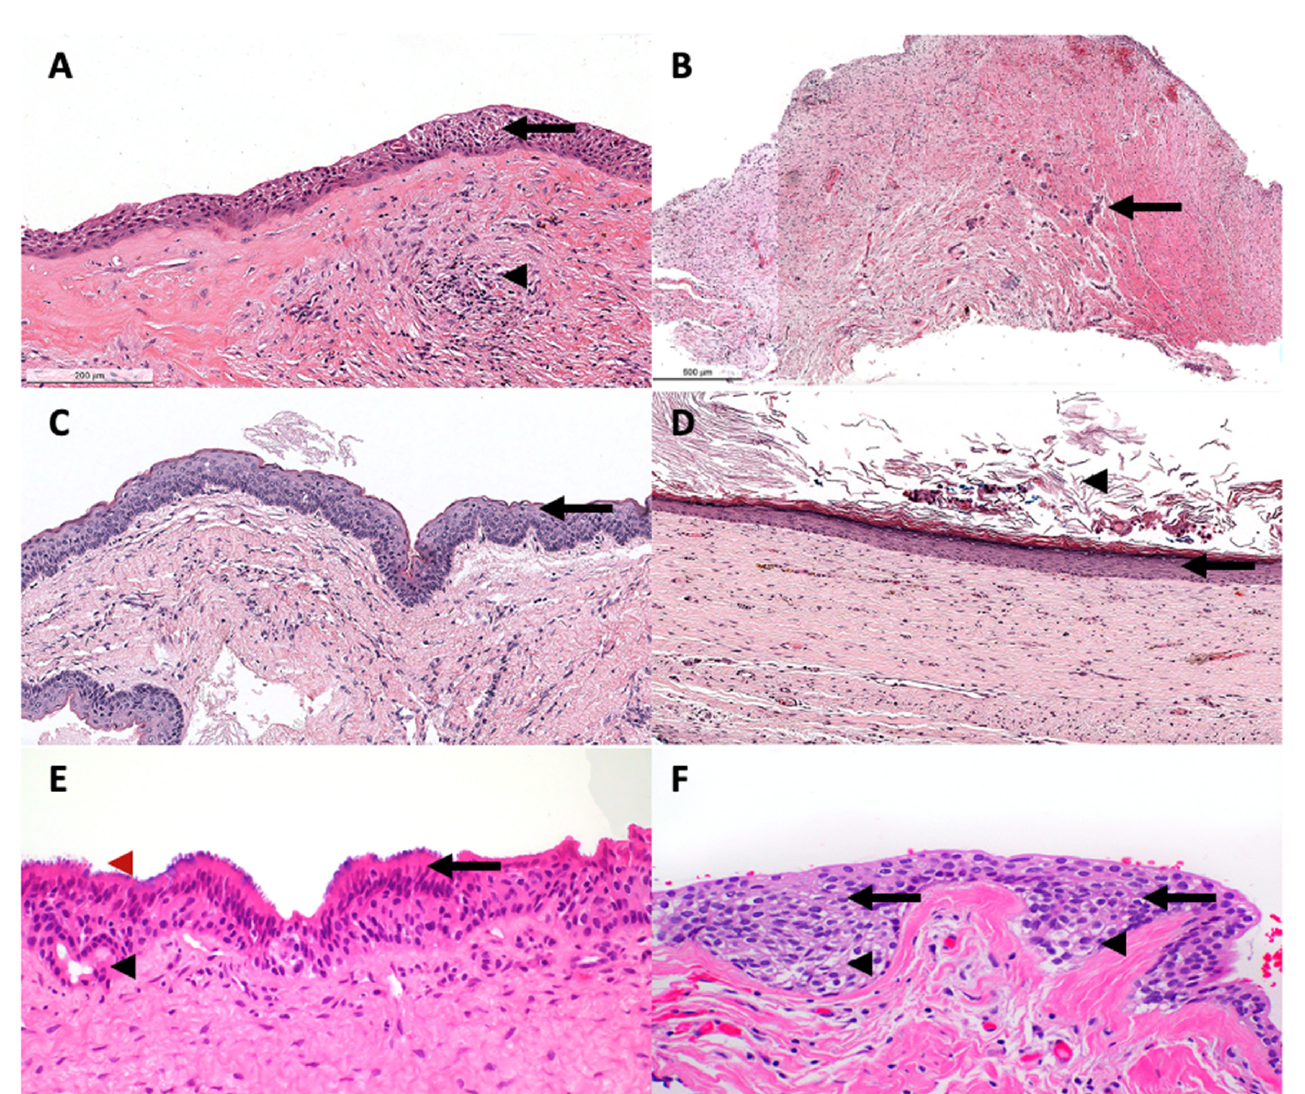
Figure 1. A representative histological photomics of developmental OCs. ( A ) DC is lined by uni- formly thin nonkeratinized squamous cell epithelium (arrow) with fibrovascular wall and scattered inflammatory cells (arrowhead). EC show similar histological features to DC; however, located in the lamina propria ( B ) Hyperplastic dental follicle consists of delicate fibrocollegenous stroma with scattered odontogenic epithelial islands (arrow). ( C ) OKC is lined by uniformly thin parakeratinzed squamous cell epithelium with surface corrugation and hyperchromatic basal cell layer (arrow). ( D ) OOC is lined by uniformly thin orthokeratinized stratified squamous epithelium (arrow) with keratin debris within the cyst lumen (arrowhead). ( E ) GOC is lined by uniformly thin nonkeratinized squamous epithelium with abluminal eosinophilic cuboidal (hobnail) cells (arrow) with ducts (black arrowhead) and cilia (red arrowhead) observed in the cyst lining. ( F ) LPC is lined by uniformly thin nonkeratinized squamous epithelium-exhibiting clear cells (arrowhead) and epithelial plaques